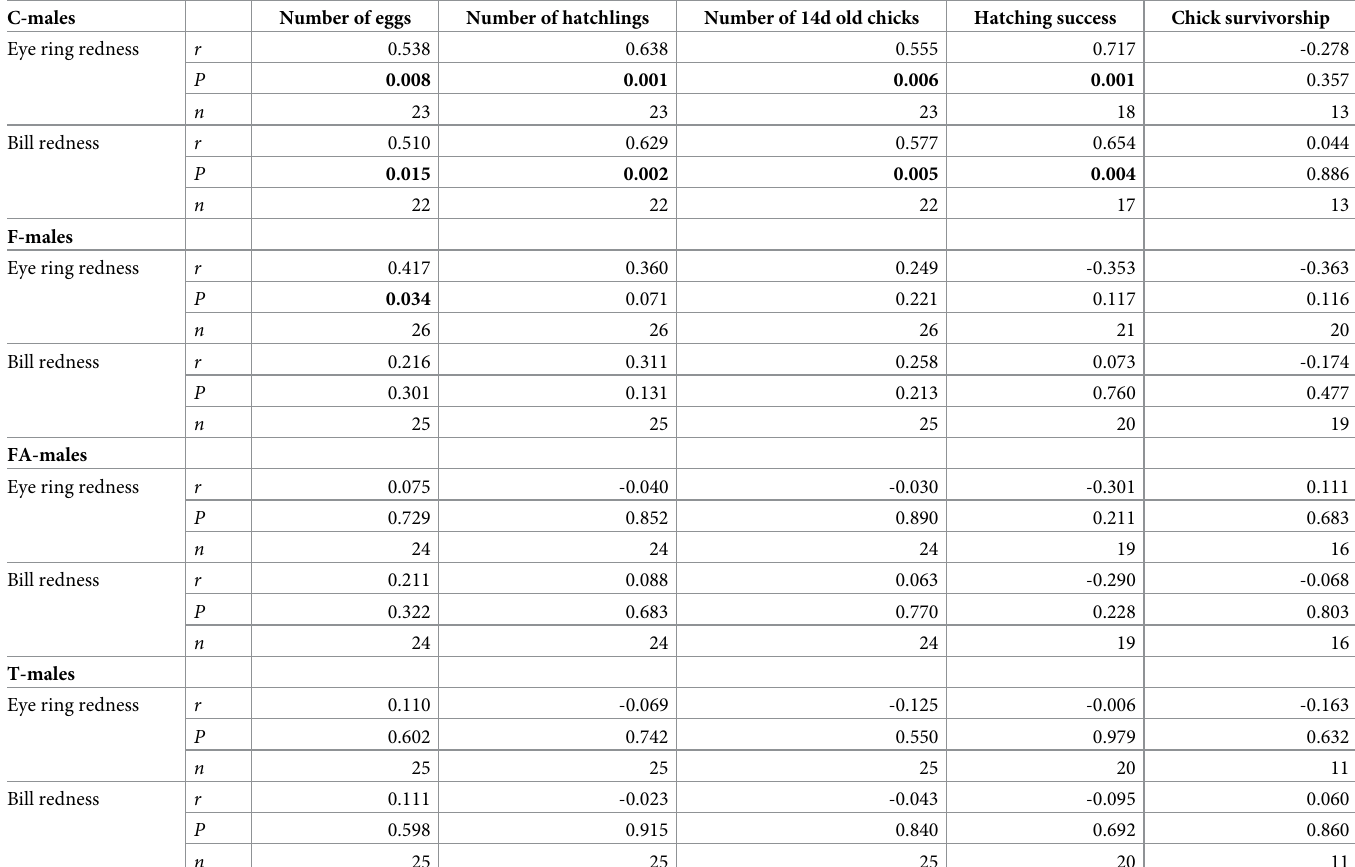
Table 3. Correlation between ornament redness and reproductive output in male red-legged